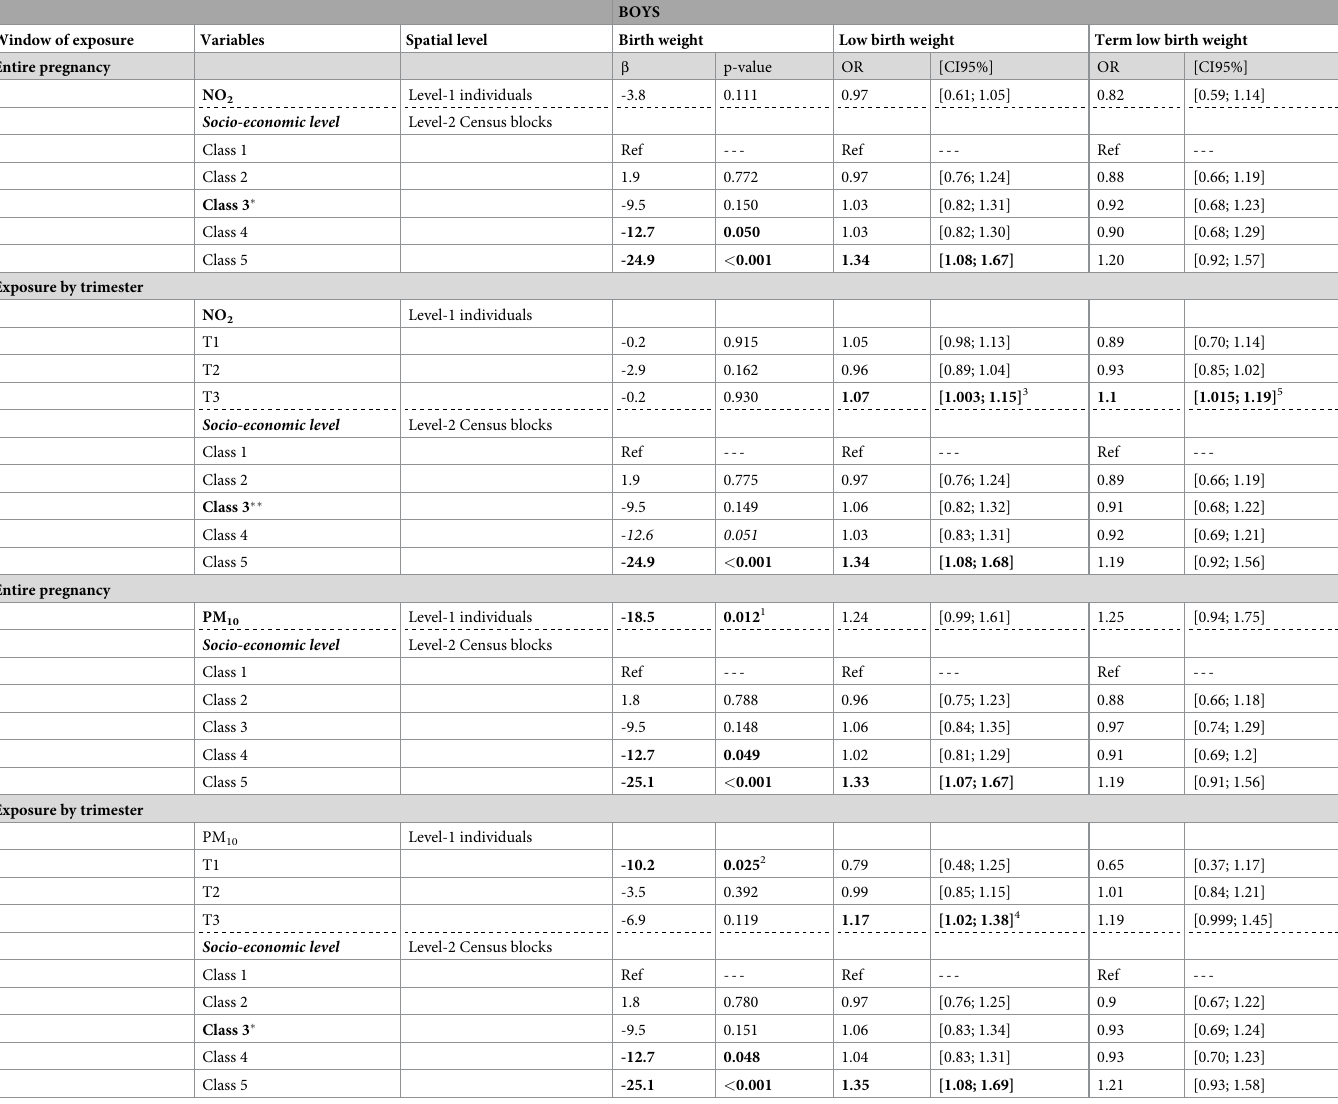
Table 7. Association between adverse birth outcome (BW, LBW, TLBW) and air pollution exposure during pregnancy plus neighborhood socioeconomic level for boys using multilevel model (defined as Model 2 in §Material and methods).